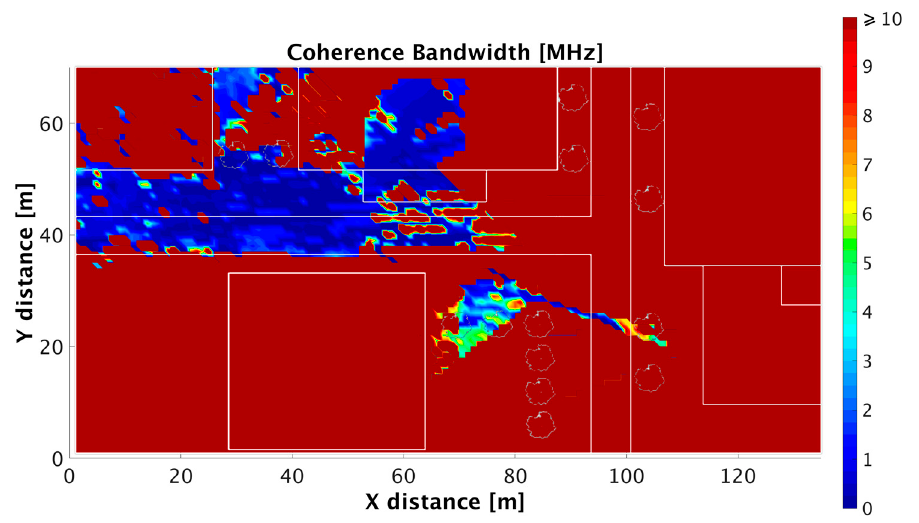
Figure 9. Coherence bandwidth for the outdoor scenario (80° beam width and 180° antenna orientation) at the bi-dimensional plane of 1.3 m height.